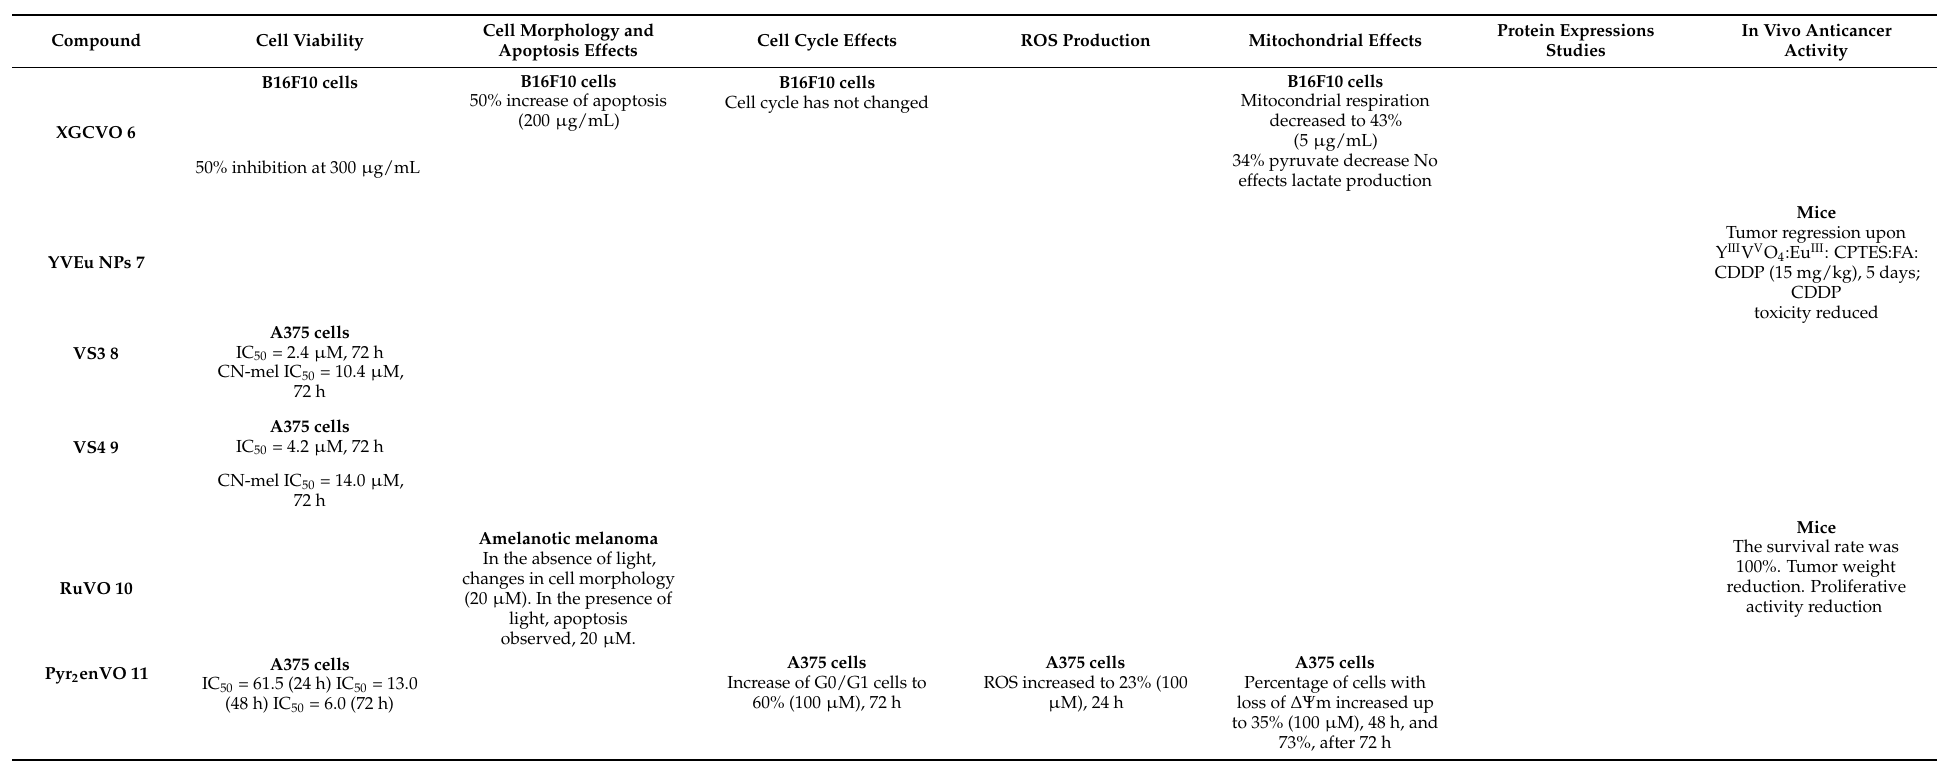
Mice Tumor regression upon Y III V V O 4 :Eu III :